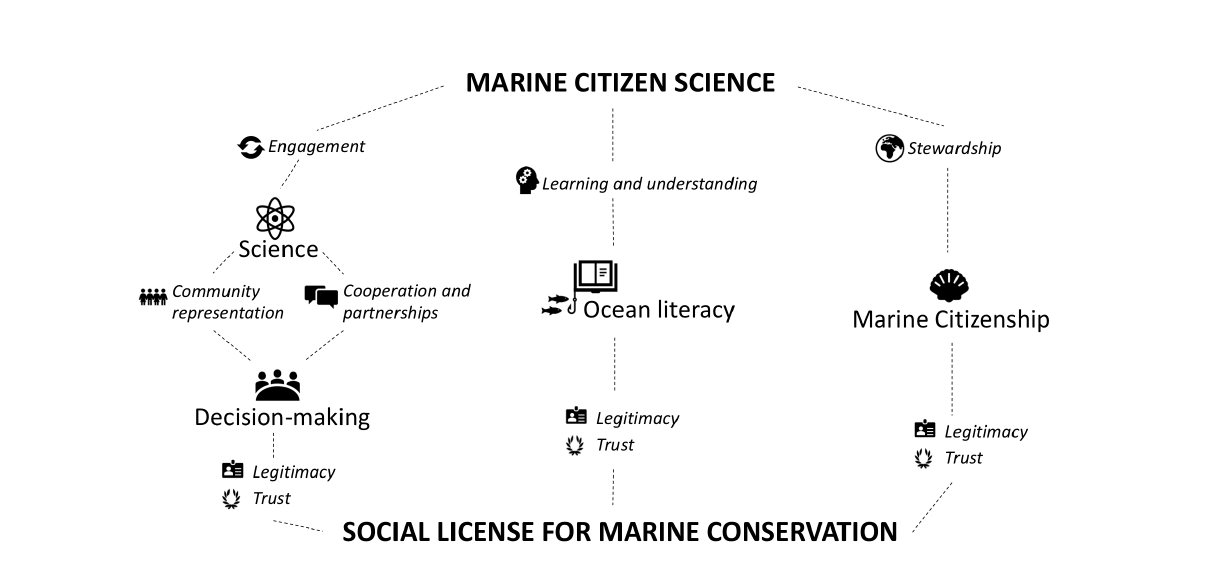
Fig. 1. Marine citizen science legitimizes science to the public and enhances ocean literacy and marine citizenship to enhance social license for marine